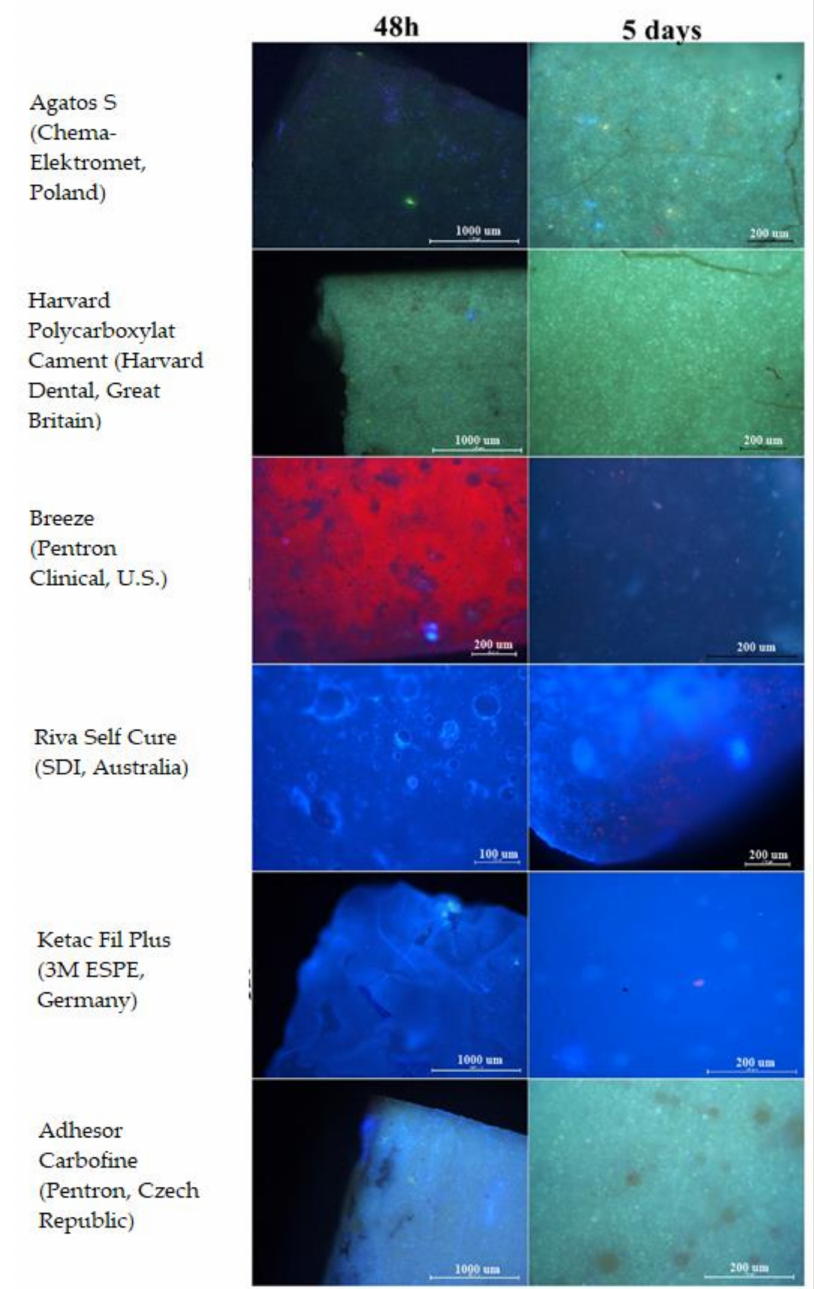
Figure 8. Adhesion of NHDF cells on cement surface after 48 h and 5